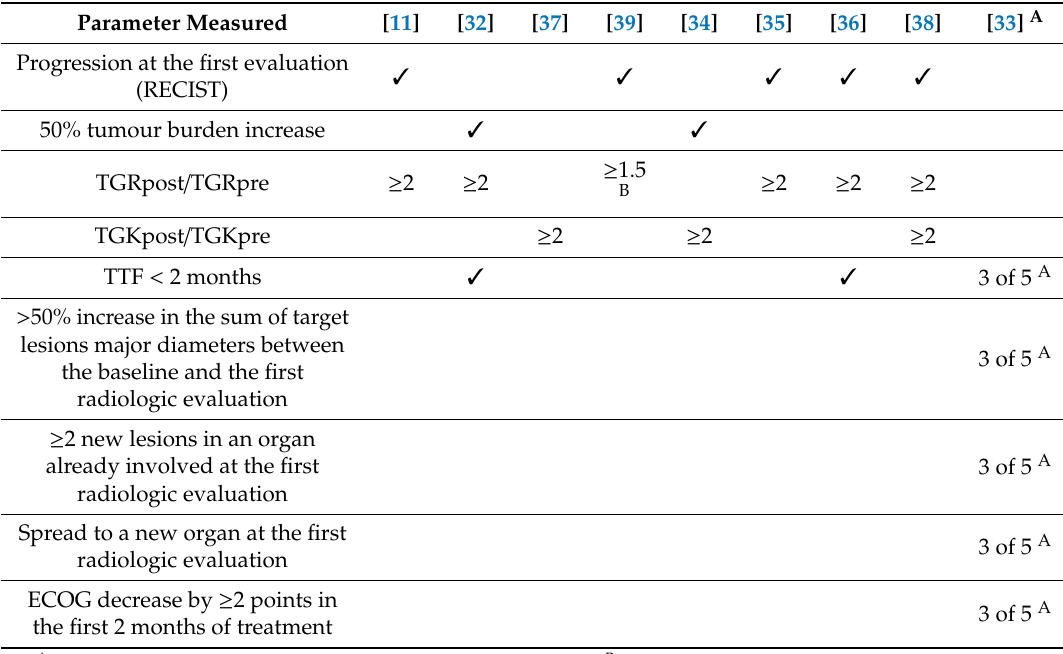
Table 2. Criteria included in di ff erent HPD